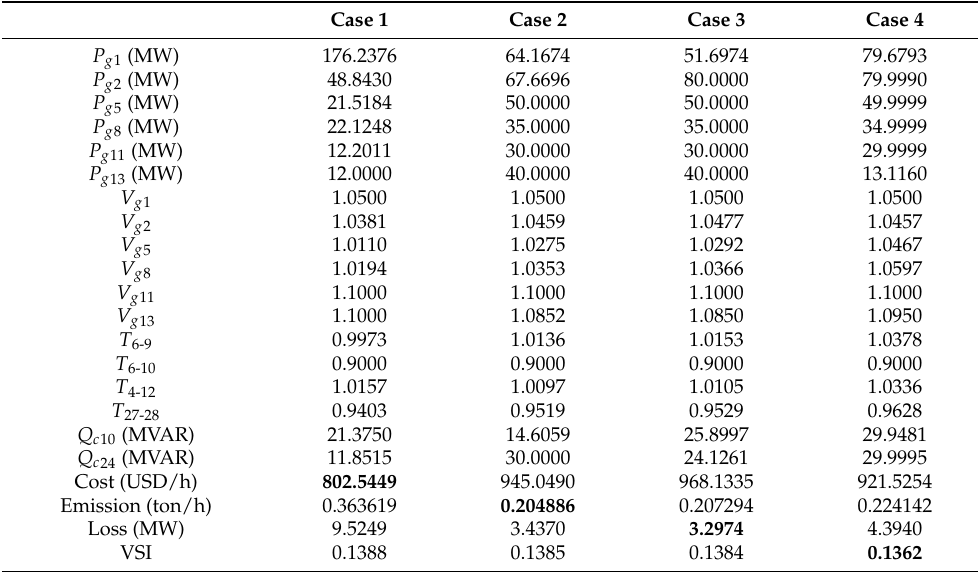
Table A1. Optimal solutions provided by MaMPA in the IEEE 30-bus systems for cases 1–4.